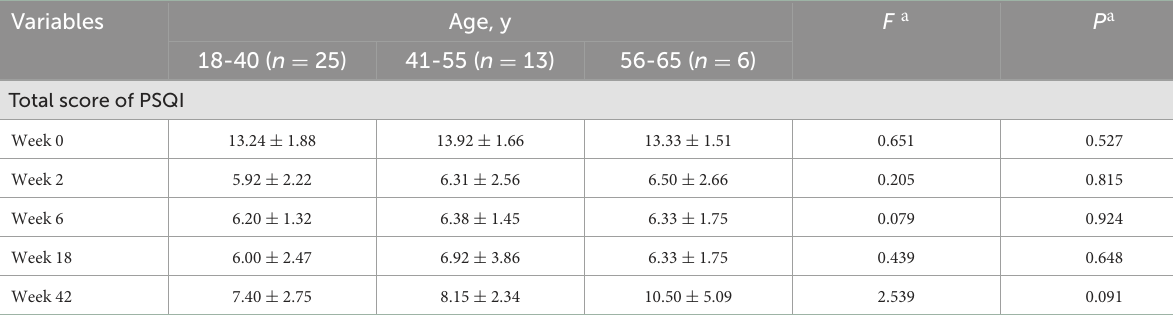
TABLE 4 Difference of curative effect in different age segments of active acupuncture group.